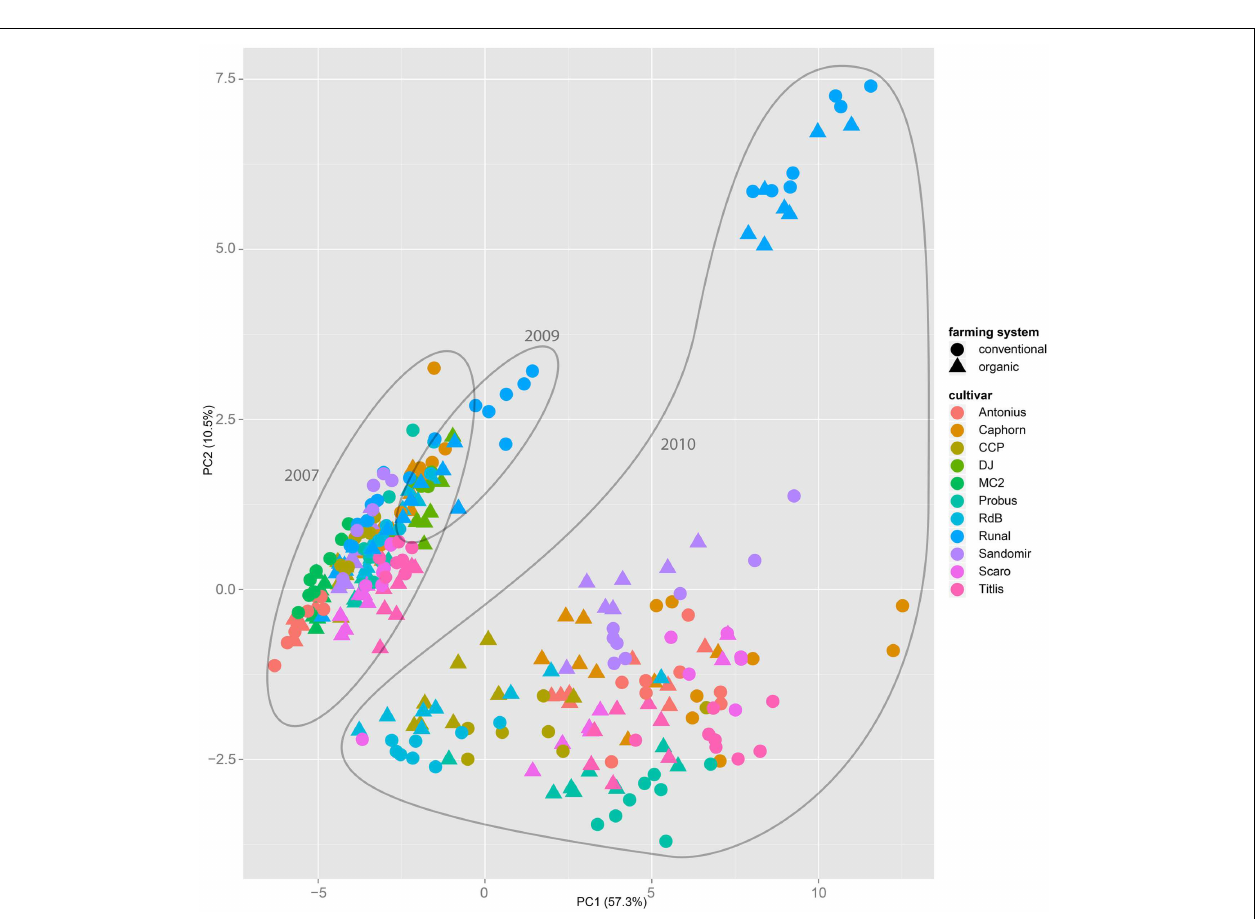
FIGURE 1 |The principal component analysis on the entire dataset of all samples throughout all years, cultivars, and treatments show that the first two components mainly separate samples by the factor year . A separation by the factor farming system is not